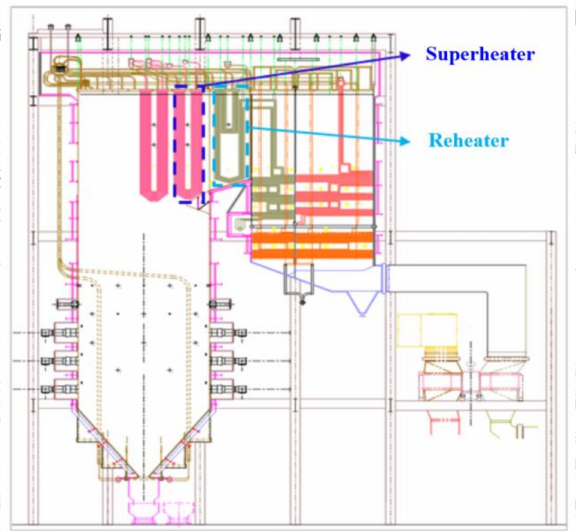
Figure 1. Tube exposed position in the